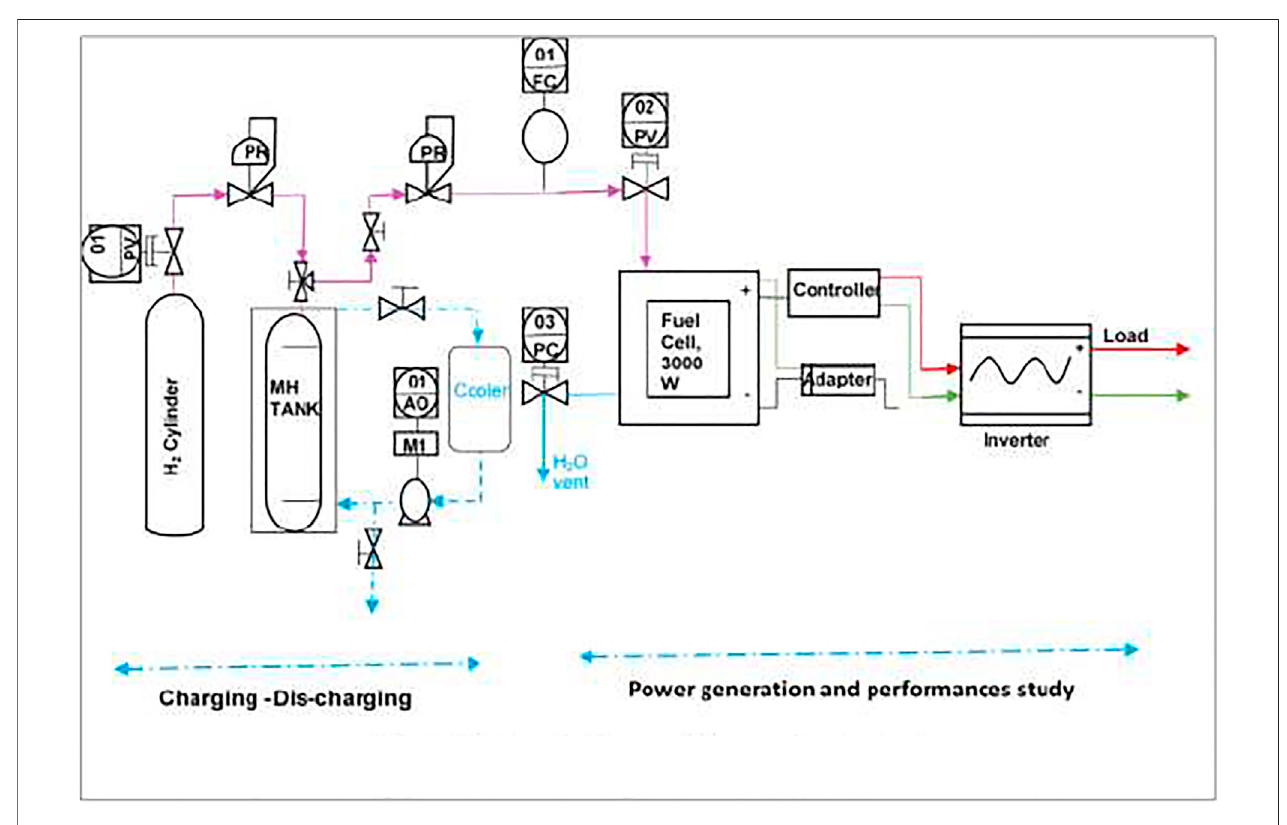
FIGURE 1 | Schematic diagram of the experimental setup.